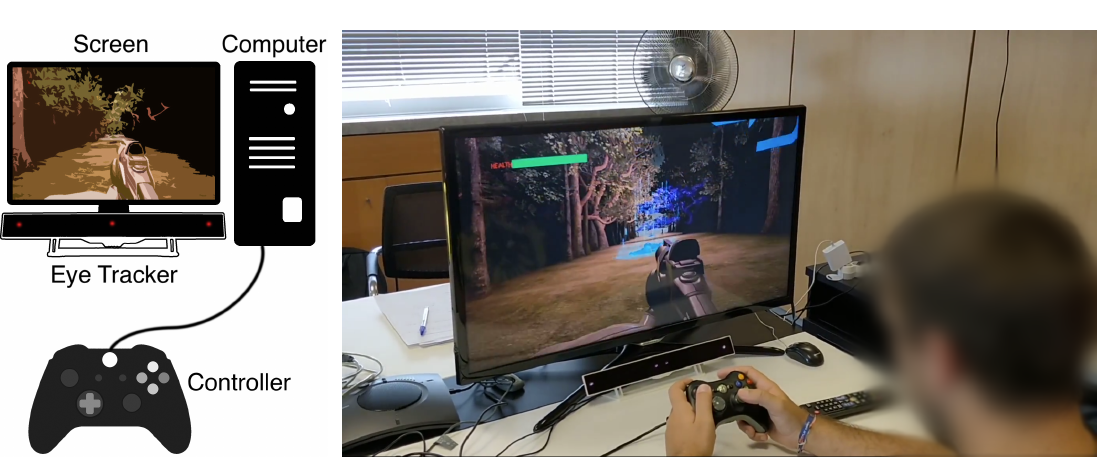
Figure 2. The hardware configuration and a test subject during an evaluation